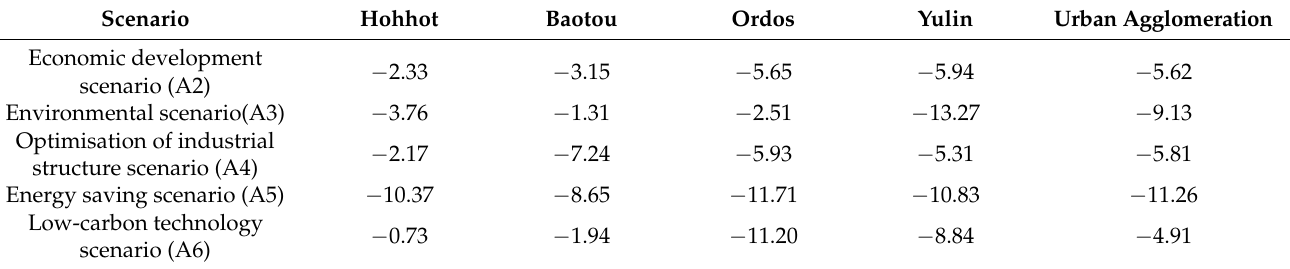
Table 9. Comprehensive regulation of carbon emissions scenario parameter setting (%).